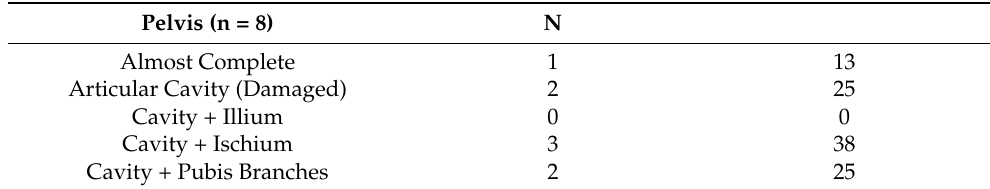
Figure 8. Two examples of pelvis compression: ( A ) Pelvis from SET 3 ventral view with damaged acetabulum (fissure marked by anarrow). ( B ) Pelvis from SET 2 also showing severe destruction leaving small portions of the original bone. Table 4. Fragments and modifications of the pelvis when compressed, most fragments retain the